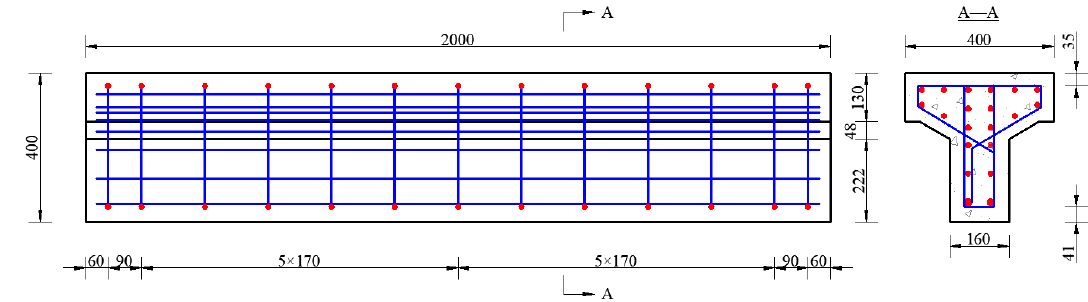
Figure 1. Section-size layout and reinforcement diagram of test beam (unit: mm).